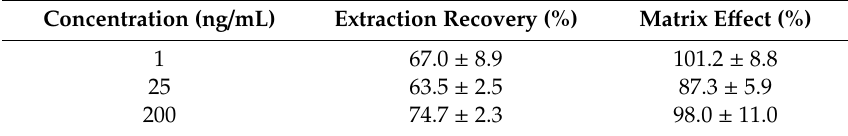
Table 3. The extraction recovery and matrix e ff ect of celastrol in rat plasma ( n = 6).